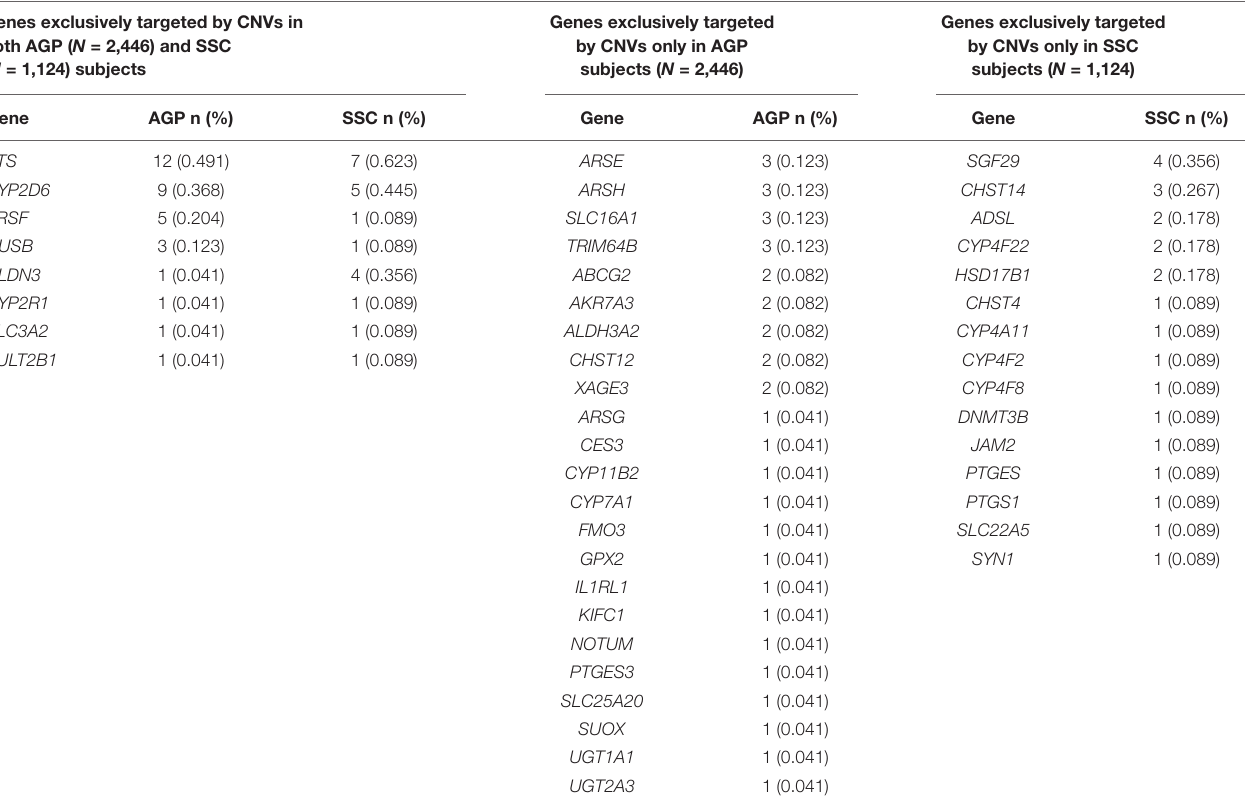
TABLE 2 | Frequencies observed for XenoReg genes targeted by CNVs exclusively in individuals with ASD from the AGP and/or SSC datasets, when compared to controls from the DGV dataset. Genes exclusively targeted by CNVs in both AGP ( N = 2,446) and SSC